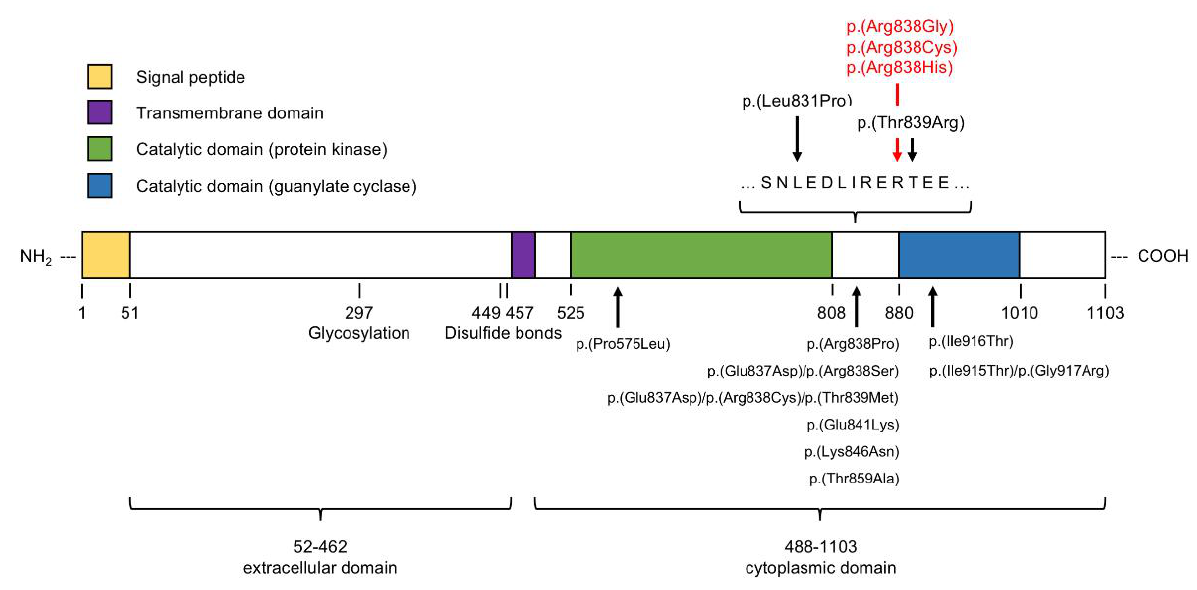
Figure 2. Schematic of the protein product as transcribed and translated from the GUCY2D gene. The extracellular domain follows a short signal peptide at the N-terminus and is subject to some posttranslational modifications (glycosylation and disulfide bonds). A short transmembrane domain links it to the cytoplasmic domain with enzymatically active domains (green and blue). All disease-causing sequence variants are located between those domains, between amino acids 830 and 840 (arrows and denominations top right). On the bottom, additional known mutations causing AD COD/CORD are indicated [13 – 33].